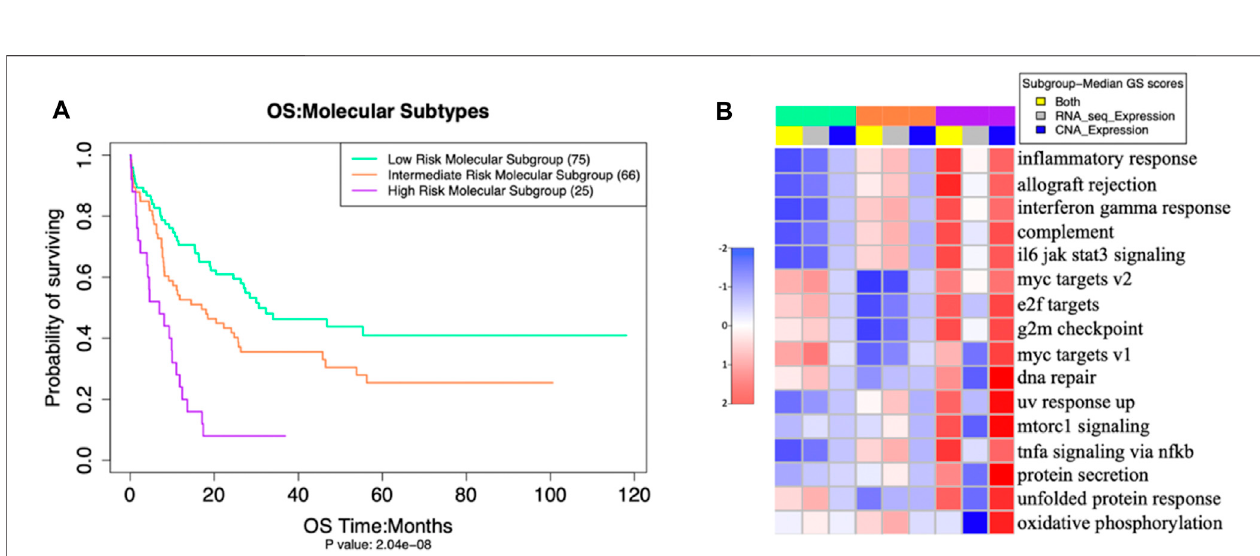
FIGURE 3 | (A) Overall Survival outcomes of our three molecular subgroups differed signi fi cantly ( p (cid:1) 2 × 10 − 8 (adjusted by gender and age) (B) activation levels of 16 pathways (in rows), also differed signi fi cantly, as measured by Multi omics Gene set Scores analysis of molecular subgroups with ANOVA test -- false discovery rate (FDR <